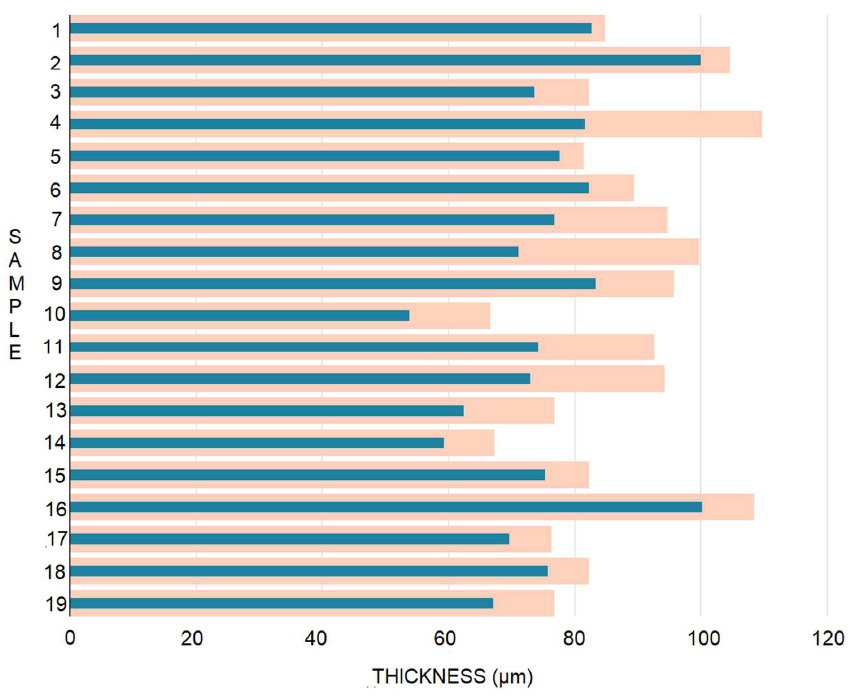
Figure 2. Sample thickness after one year of storage. T0, light brown bars; T1, blue bars.